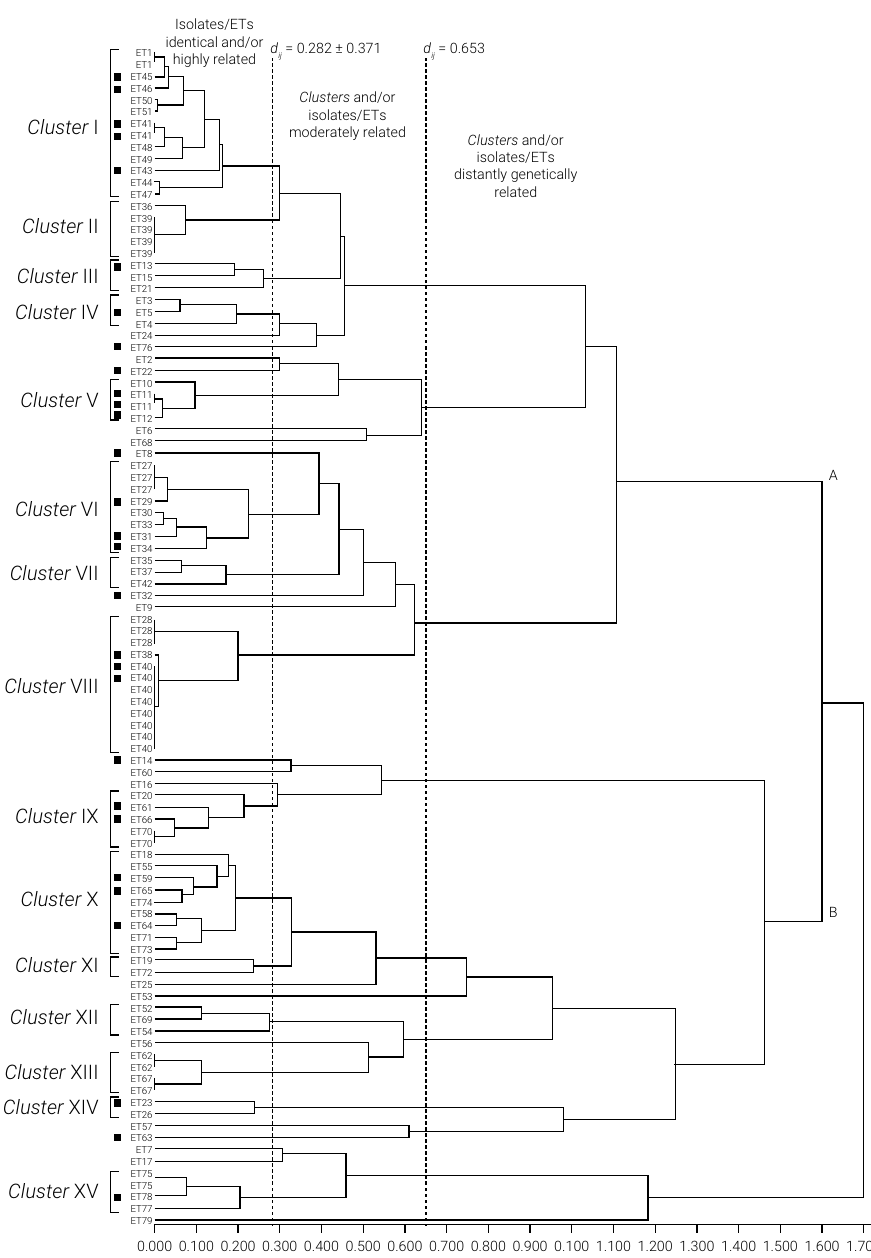
Figure 1. Genetic diversity of 99 oxacillin-resistant S. aureus isolates sourced from a population of odontological clinical and environment samples. The UPGMA dendrogram ( r from a matrix of genetic distance d (Nei, ij